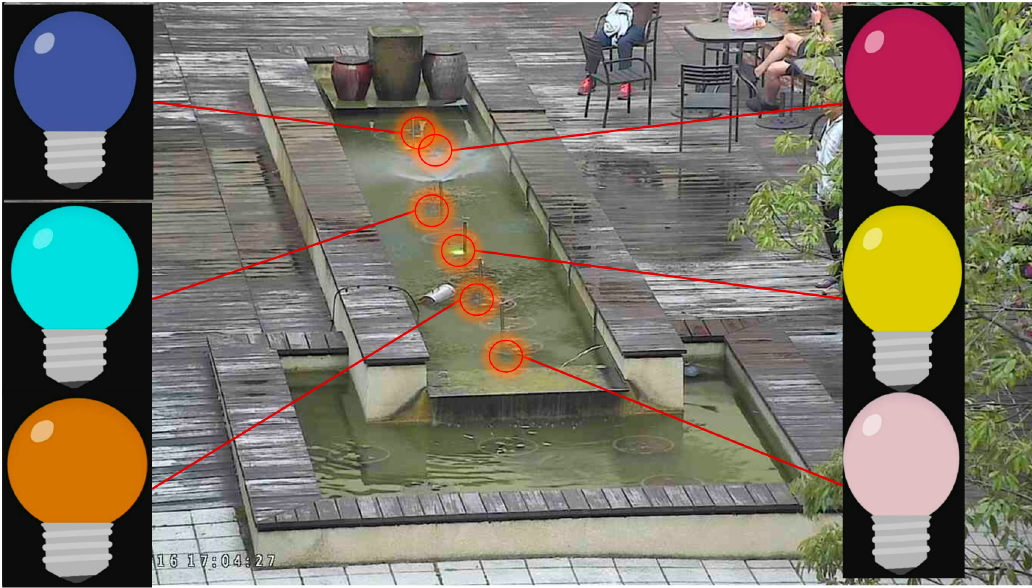
Figure 11. The real lights and the simulated lights in the water dance